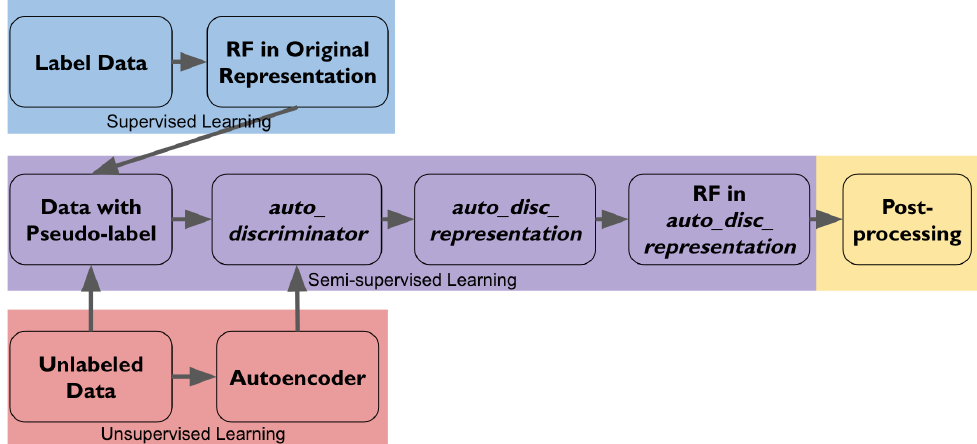
Figure 3. Pipeline of the method. Boxes in blue correspond to Section 4.1. Boxes in red correspond to Section 4.2. Boxes in purple correspond to Section 4.3. Box in yellow corresponds to Section